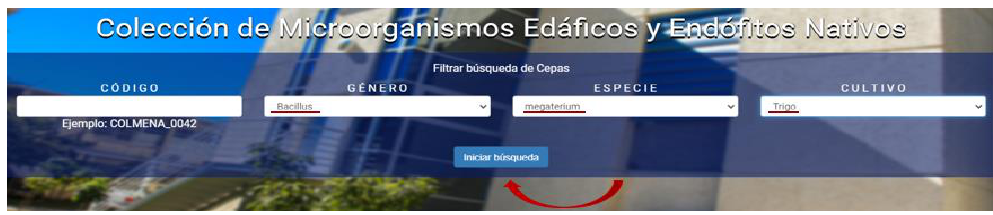
Figure 5. Filter selection in the COLMENA’s platform.